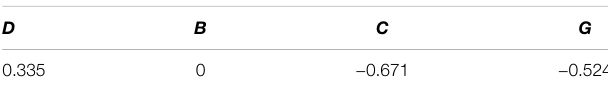
TABLE 3 | Normalized index of No. 102 communication